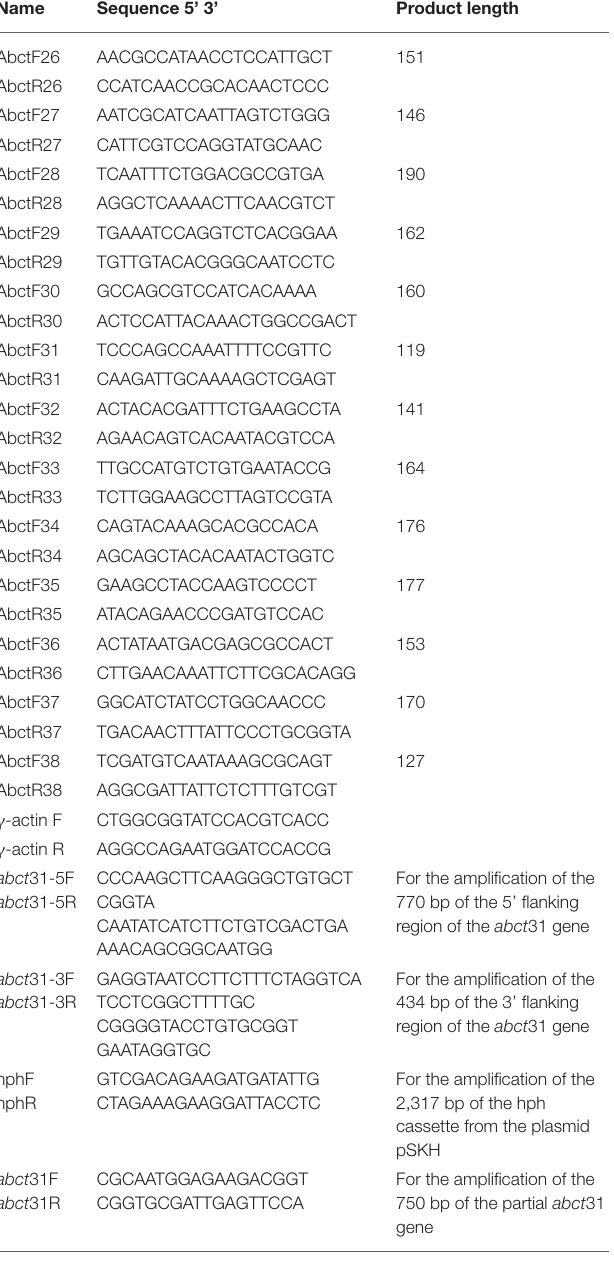
Table 1 lists the primer pairs utilized in the current